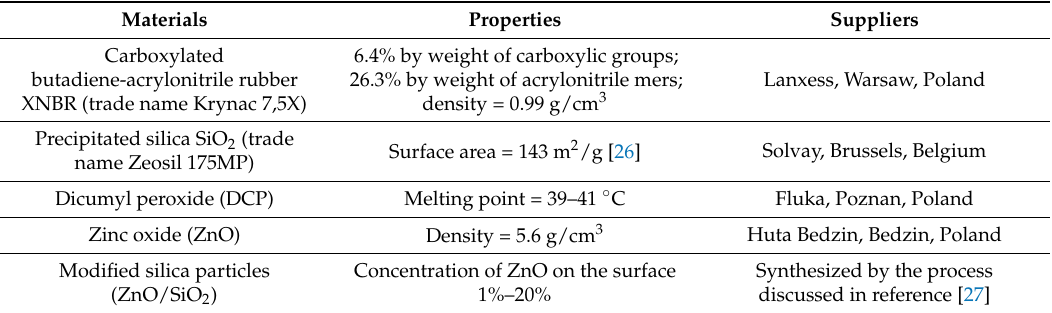
Table 1. Description of the materials used in the